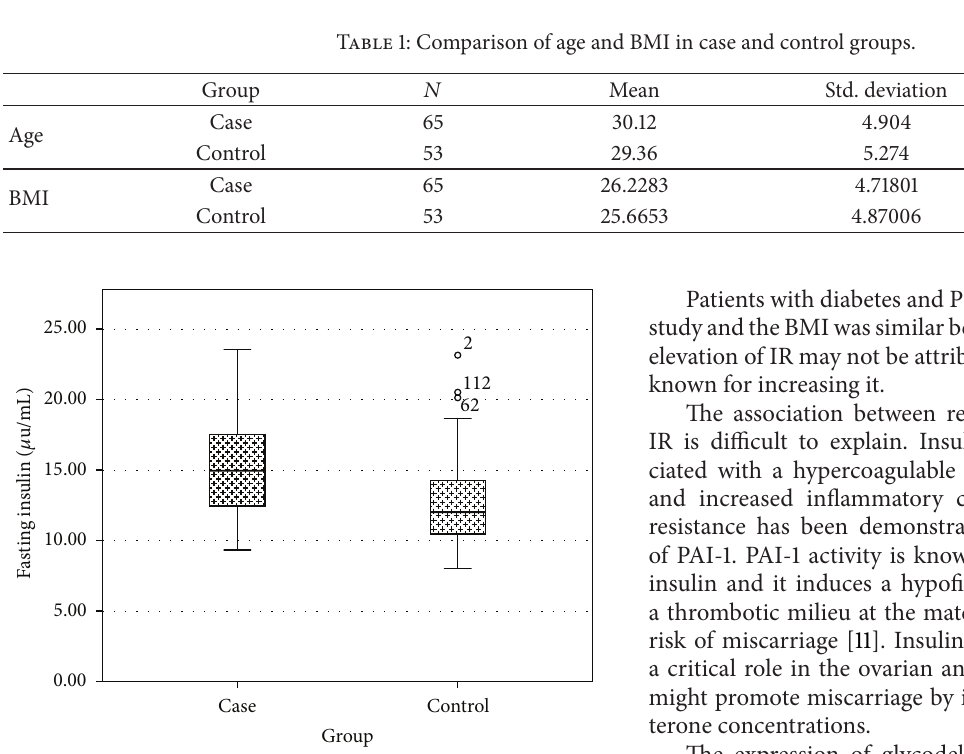
Figure 2: Comparison of fasting insulin levels in case and control groups.